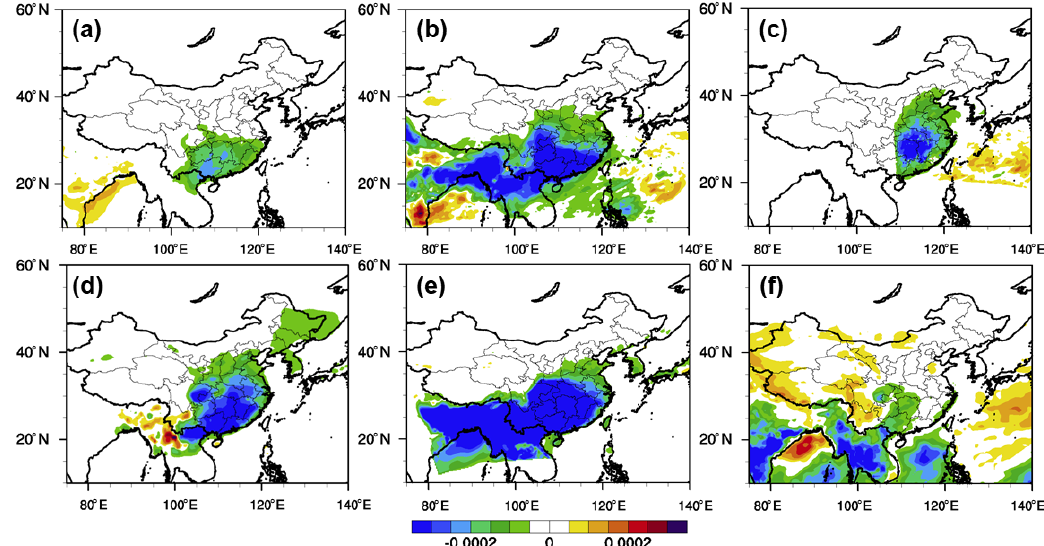
Figure 4. Monthly (January 2010) mean changes in water vapor at 2m (Q2, kgkg − 1 ) due to aerosol radiative effects from M1 (a) , M2 (b) , M4 (c) , M5 (d) , M6 (e) , M7 (f) (M1: Pusan National University; M2: University of Iowa; M4: NASA; M5: Institute of Atmospheric Physics; M6: Nanjing University; M7: University of Tennessee; Gao et al., 2018a).